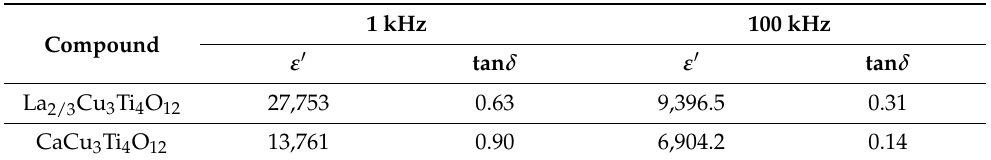
Table 2. Dielectric properties of La 2/3 Cu 3 Ti 4 O 12 and CaCu 3 Ti 4 O 12 ceramics at 298 K and different frequencies.